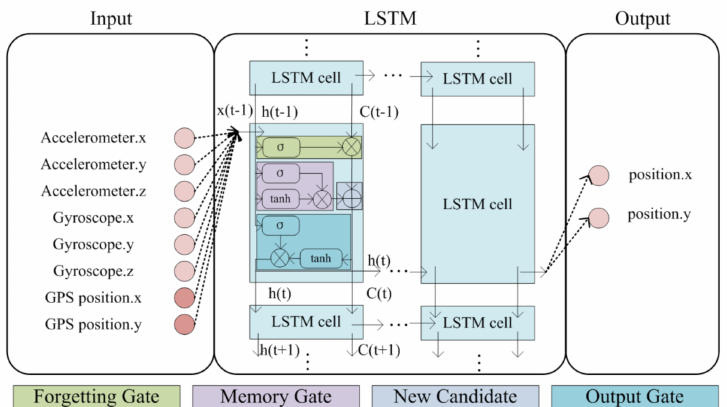
Figure 1. The LSTM net structure of inertial position estimation.